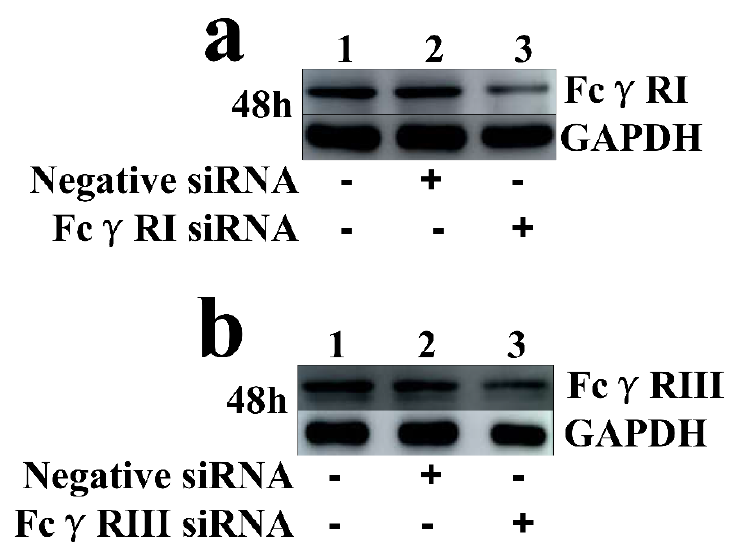
Figure 6. Immunoblot analysis of protein expression of Fc γ RI or Fc γ RIII in porcine AMs. ( a ) Fc γ RI protein level in cells transfected with Fc γ RI siRNA or negative siRNA for 48 h was quantified bywestern blot. ( b ) Fc γ RIII protein level in cells transfected with Fc γ RIII siRNA or negative siRNA for 48 h was quantified by western blot. The GAPDH served as a loading control. Note: siRNA: small interfering RNA; Fc γ RI: Fc gamma receptor I; Fc γ RIII: Fc gamma receptor III; GAPDH: glyceraldehyde-3-phosphate dehydrogenase.